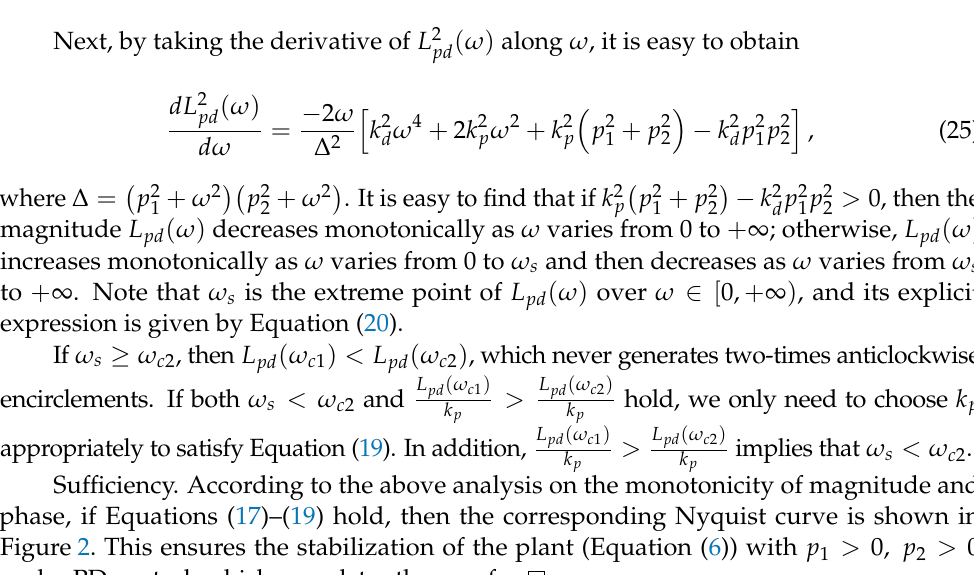
Figure 2. Nyquist curve with ω > 0 for stabilization of the plant (Equation